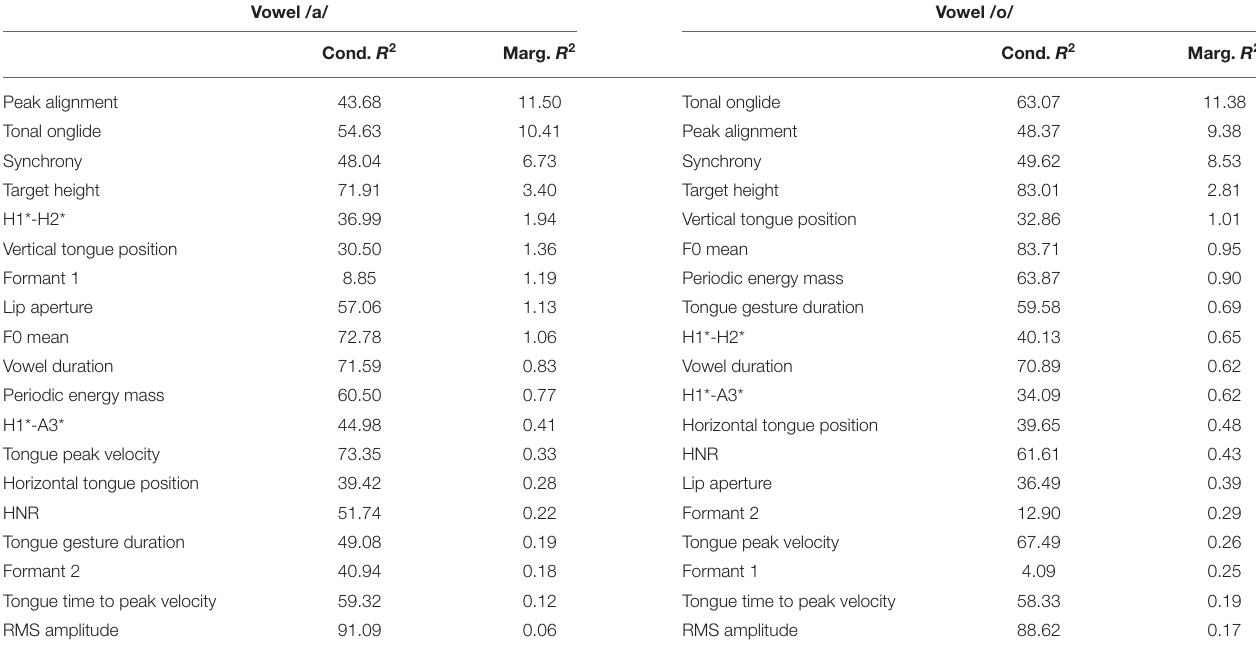
TABLE 4 | Conditional and marginal R 2 of the focus types models (expressed in